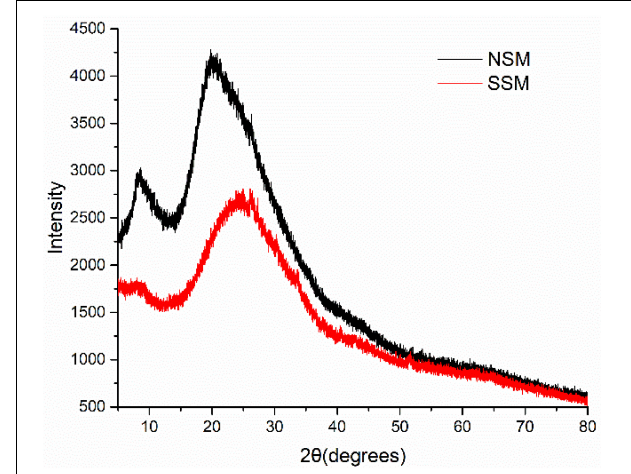
color difference ( (cid:49) E) of steam-exploded soybean meal powders varied from 8.60 to 28.20, which was typically used to evaluate the degree of the total differences between steam-exploded and native soybean meal powders. The chroma values of steam-exploded